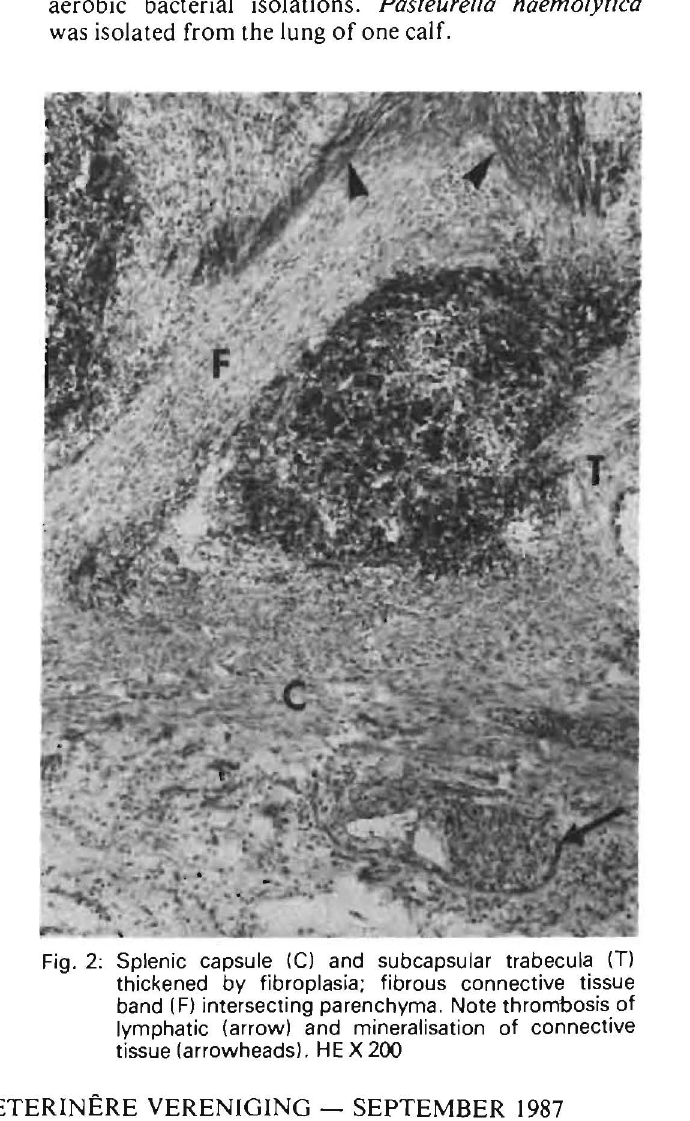
Fig. 2: Splenic capsule (e) and subcapsular trabecula (T) thickened by fibroplasia; fibrous connective tissue band (F) intersecting parenchyma. Note thrombosis of lymphatic (arrow) and mineralisation of connective tissue (arrowheads). HE X 200